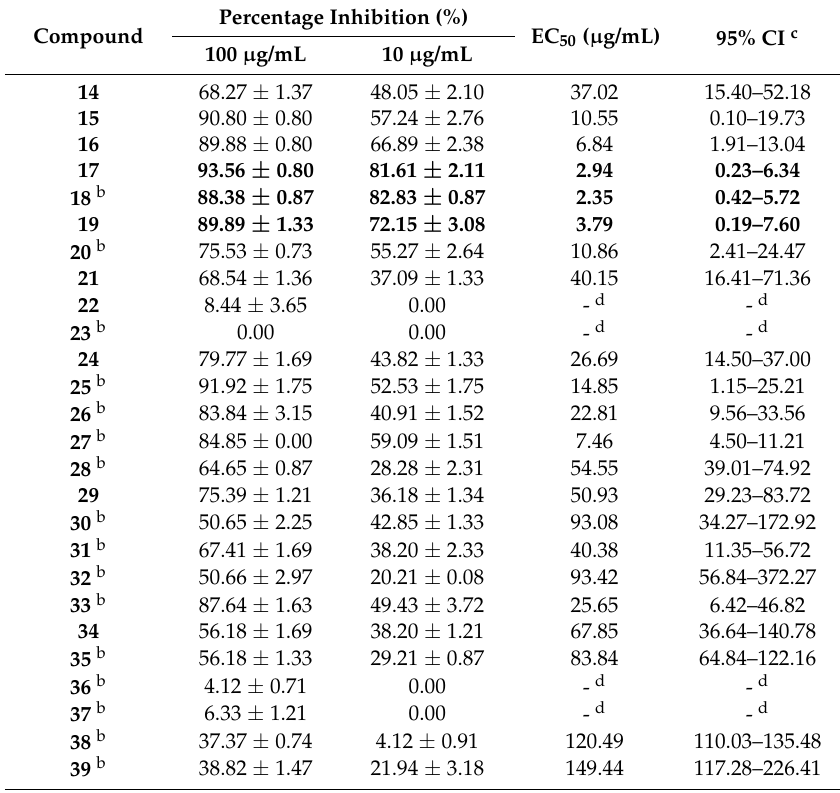
Table 2. In vitro fungicidal activity of compounds 14 – 39 . a